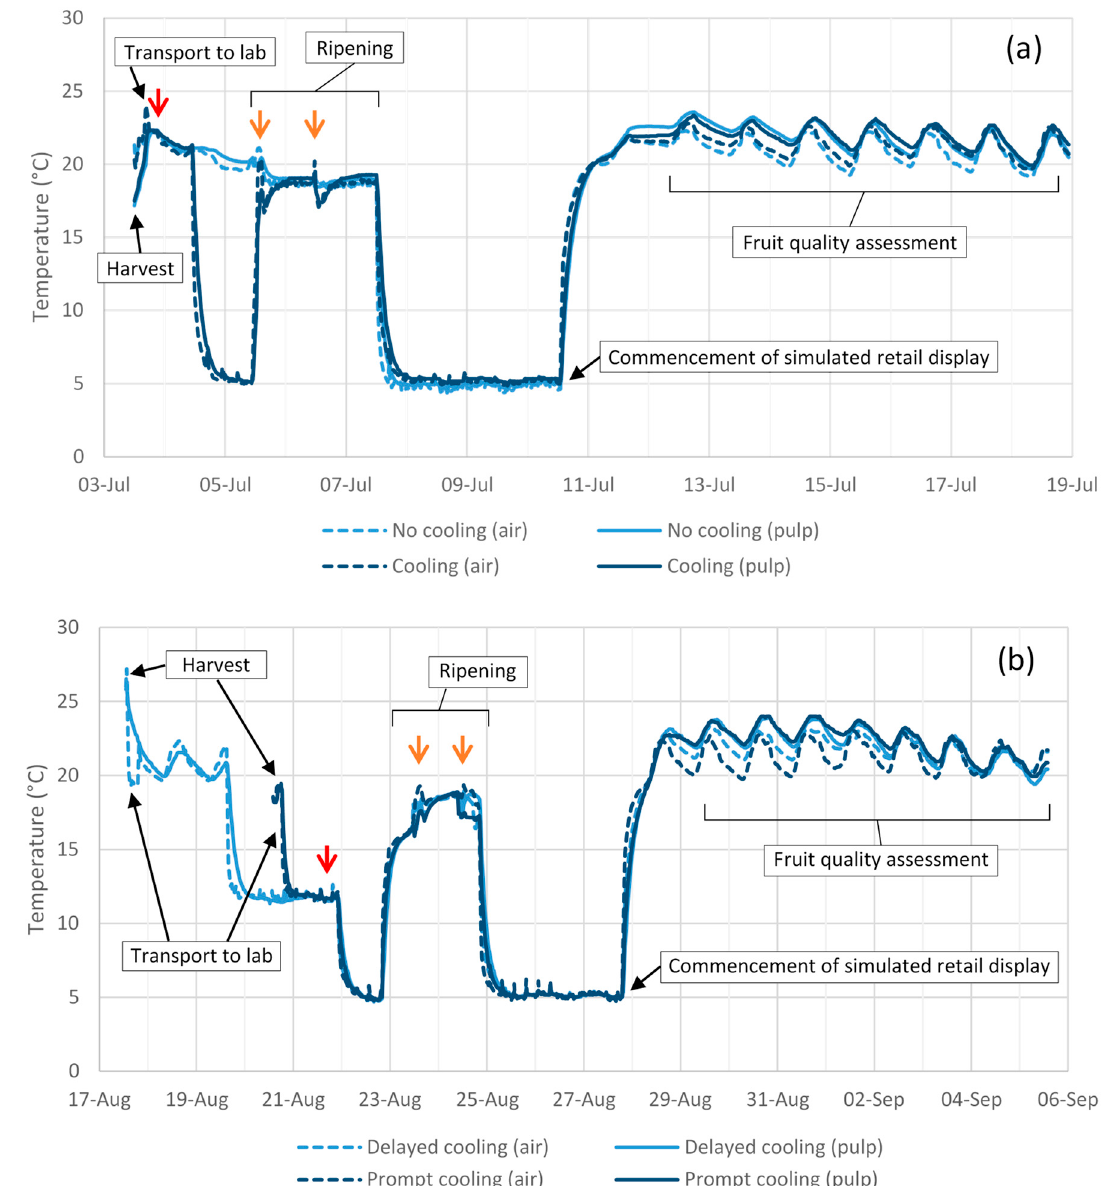
Figure 1. Air and fruit pulp temperature profiles for postharvest temperature treatments applied to 2018 season ‘Hass’ avocado fruit for ( a ) Experiment 6 and ( b ) Experiment 7. The red arrows indicate the time of impact treatment and the orange arrows indicate the time of ethephon application.